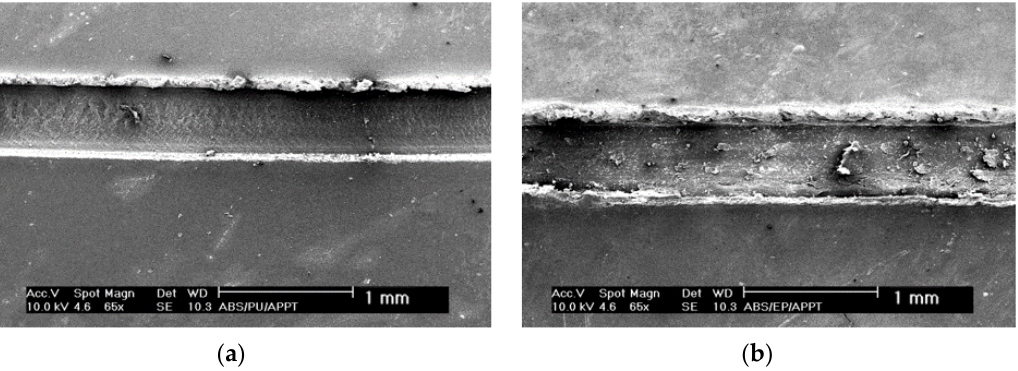
Figure 4. Scratch test on ABS: Micrographs with polyurethane ( a ) ABS + APPT/PU and epoxy ( b ) ABS + APPT/EP after treatment.